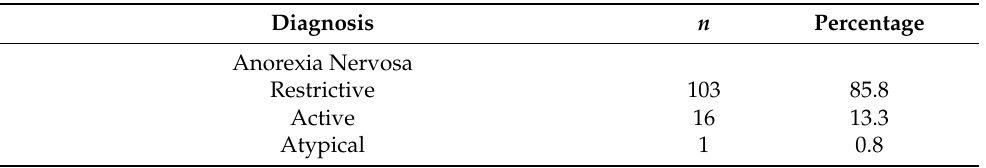
Table 3. Clinical details including anorexia nervosa subtype, psychiatric comorbidities and medica- tions at baseline for patients included in the data